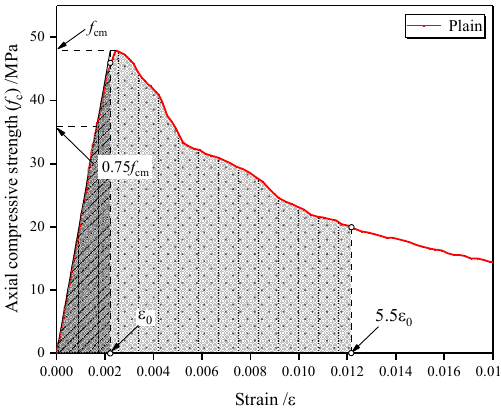
Figure 14. Schematic representation of ductility.